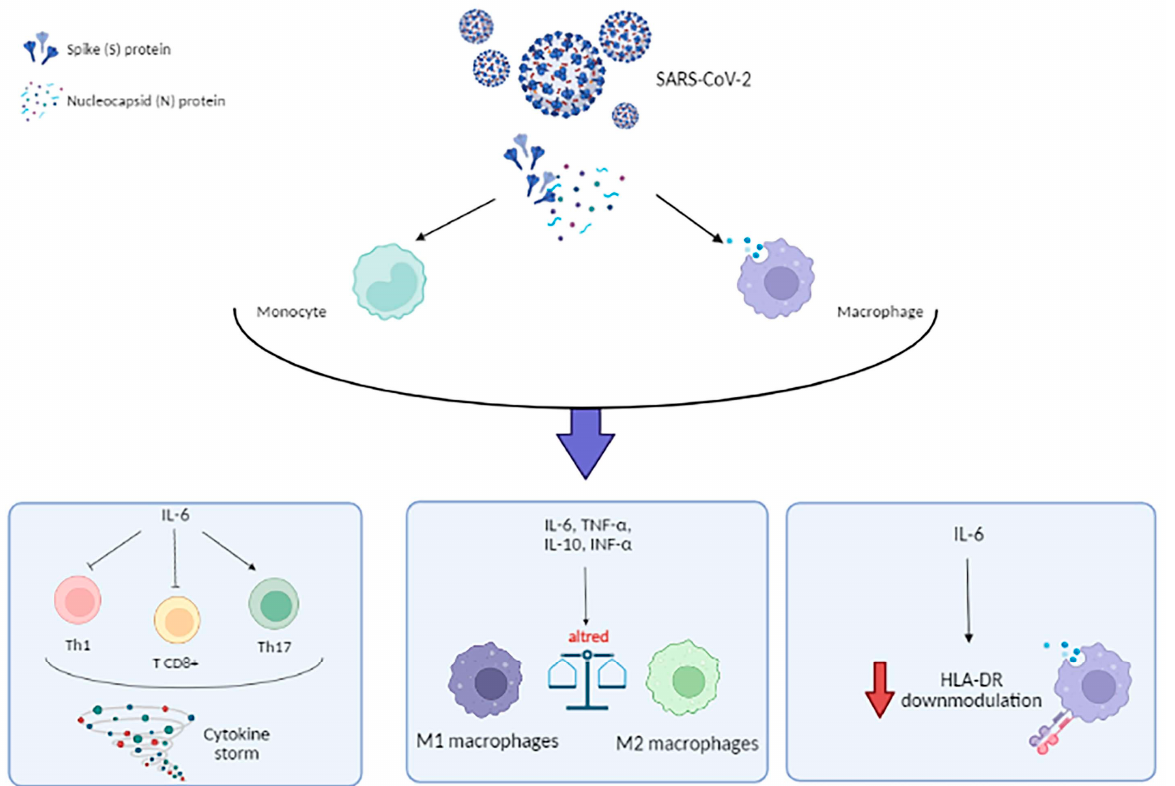
Figure 5. Schematic representation of monocytes/macrophages activation by SARS-CoV-2 Spike (S) and Nucleocapsid (N) proteins and their effect on cytokine profile and Human Leukocyte Antigen-DR (HLA-DR) down-modulation.